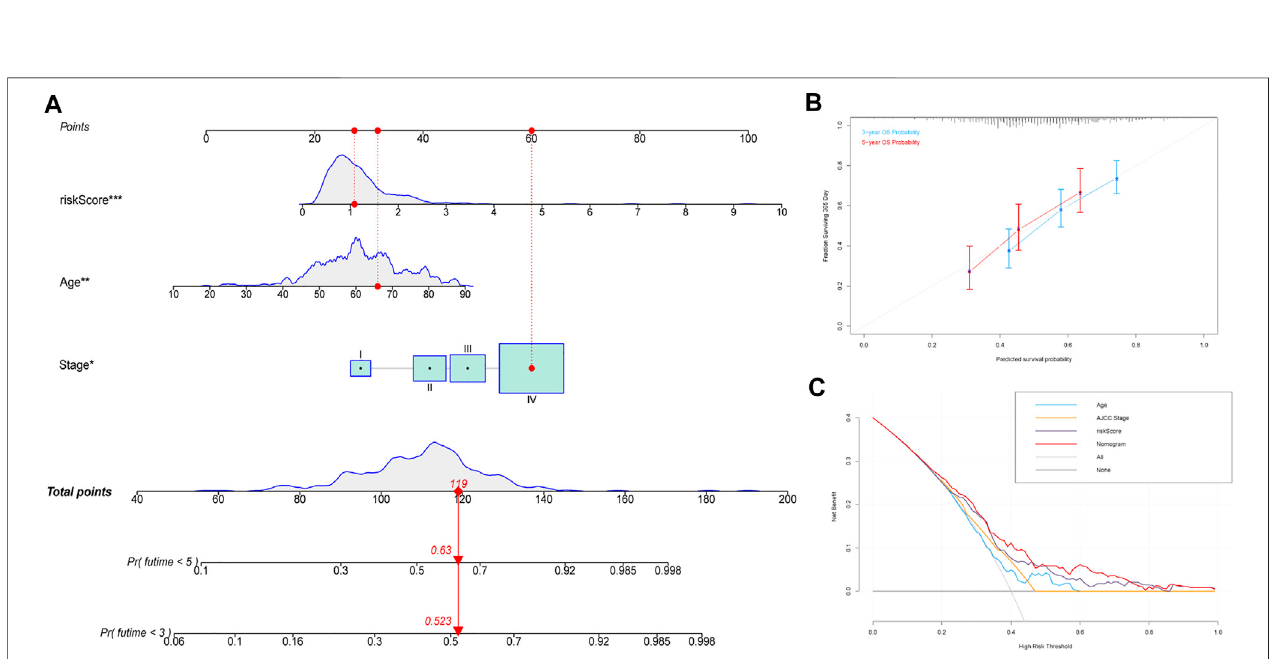
FIGURE 7 | Construction of the predictive nomogram. (A) Nomogram predicting the OS probability for patients with HNSCC. (B) Calibration curves of the nomogram for predicting the OS at 3 and 5 years. (C) DCA analysis showing the performance of the nomogram. Abbreviations: HNSCC, head and neck squamous cell carcinoma; OS, overall